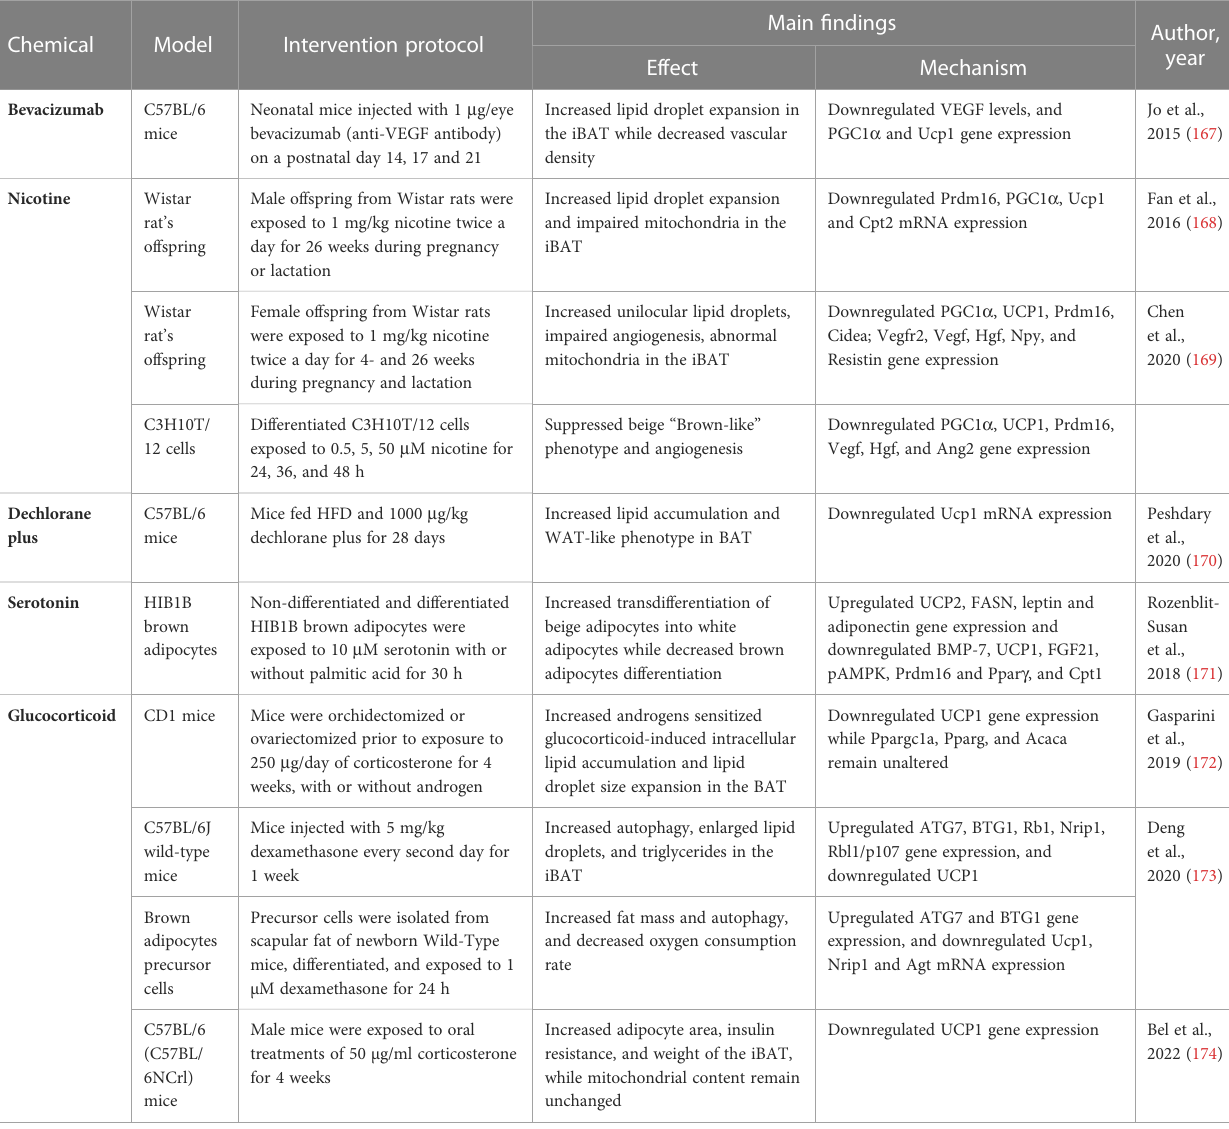
TABLE 2 Summary of evidence reporting on BAT/beige adipose tissue whitening induced by chemicals like bevacizumab, nicotine, dechlorane plus, serotonin and glucocorticoid.